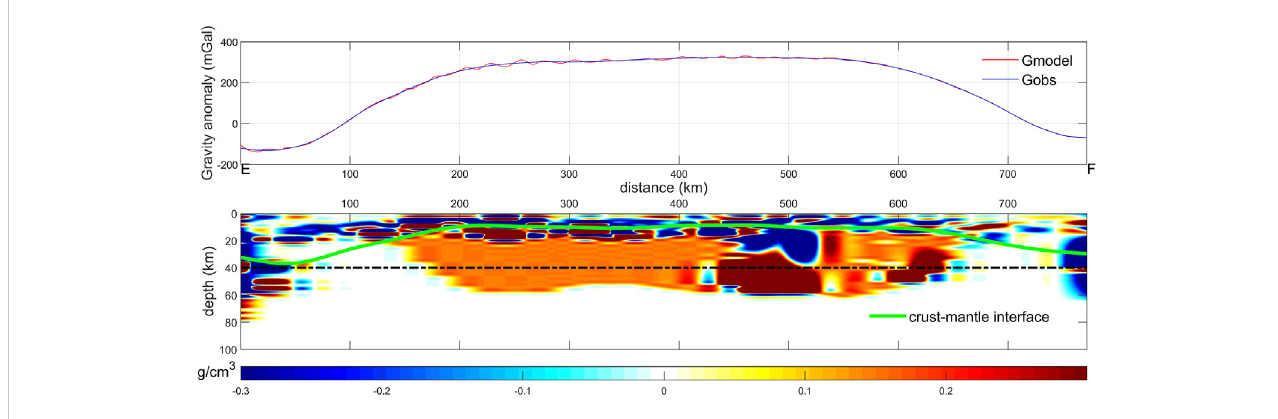
FIGURE 10 Inverted pro fi le density anomaly distribution of E-F in the Mare Serenitatis. The green solid line is the lunar crust-mantle interface. The black dashed line represents the depth of 40 km, which is for assistant analysis.